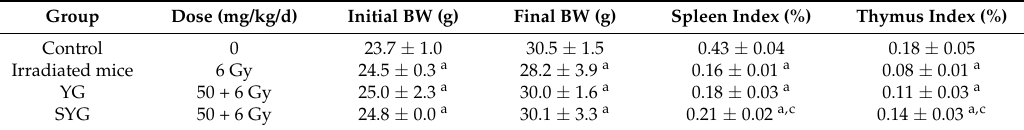
Table 3. Effects on body weight (BW) and the immune organ indexes of mice radiated using 60 Co ( n =